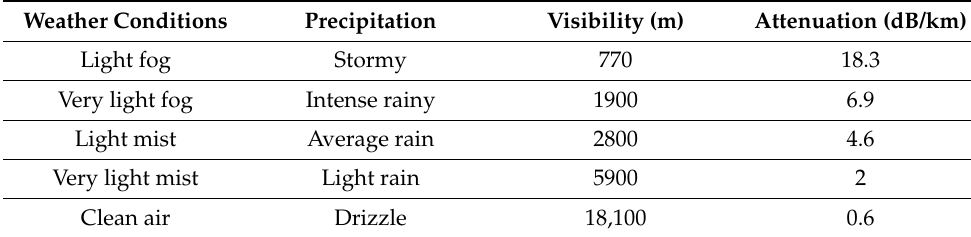
Table 3. International visibility code [38].